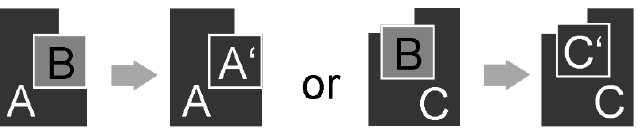
Figure A1 Example for reclassification based on spatial and spectral proximity. Figure A1. Example for reclassification based on spatial and spectral